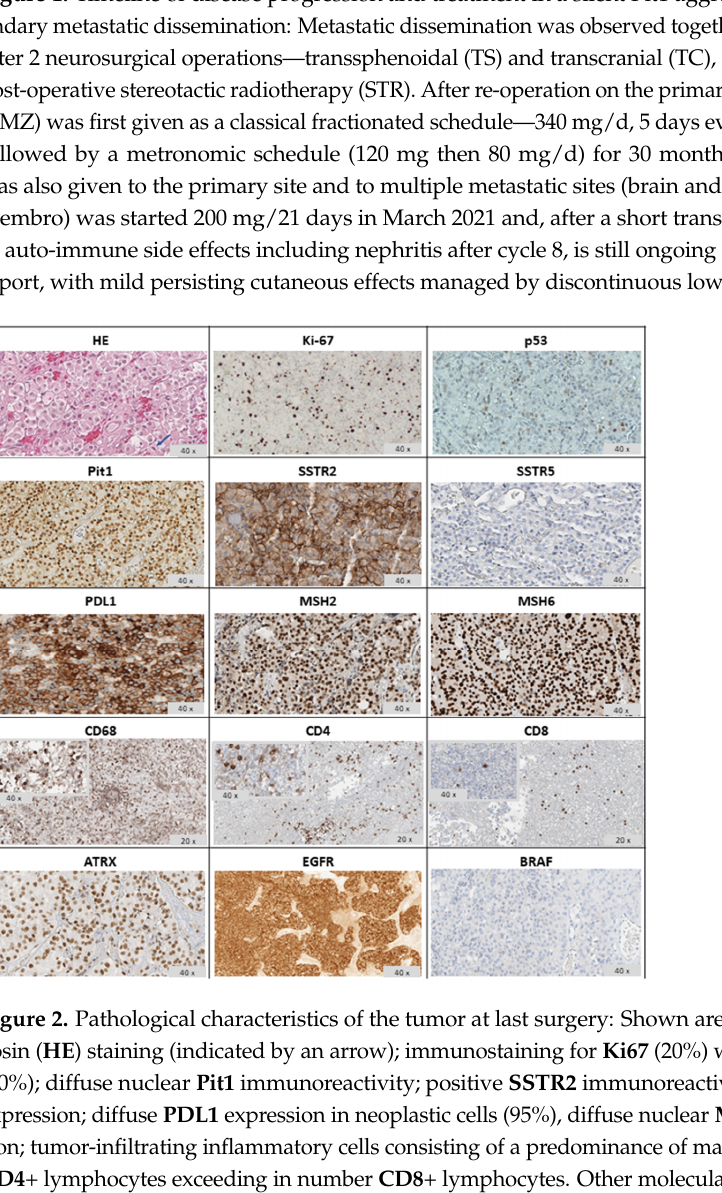
Figure 3. Radiological response to pembrolizumab: Shown are representative MRI obtained before ( A – D ) and after 1 year of treatment ( E – H ) in the patient affected by a silent metastatic Pit1-positive